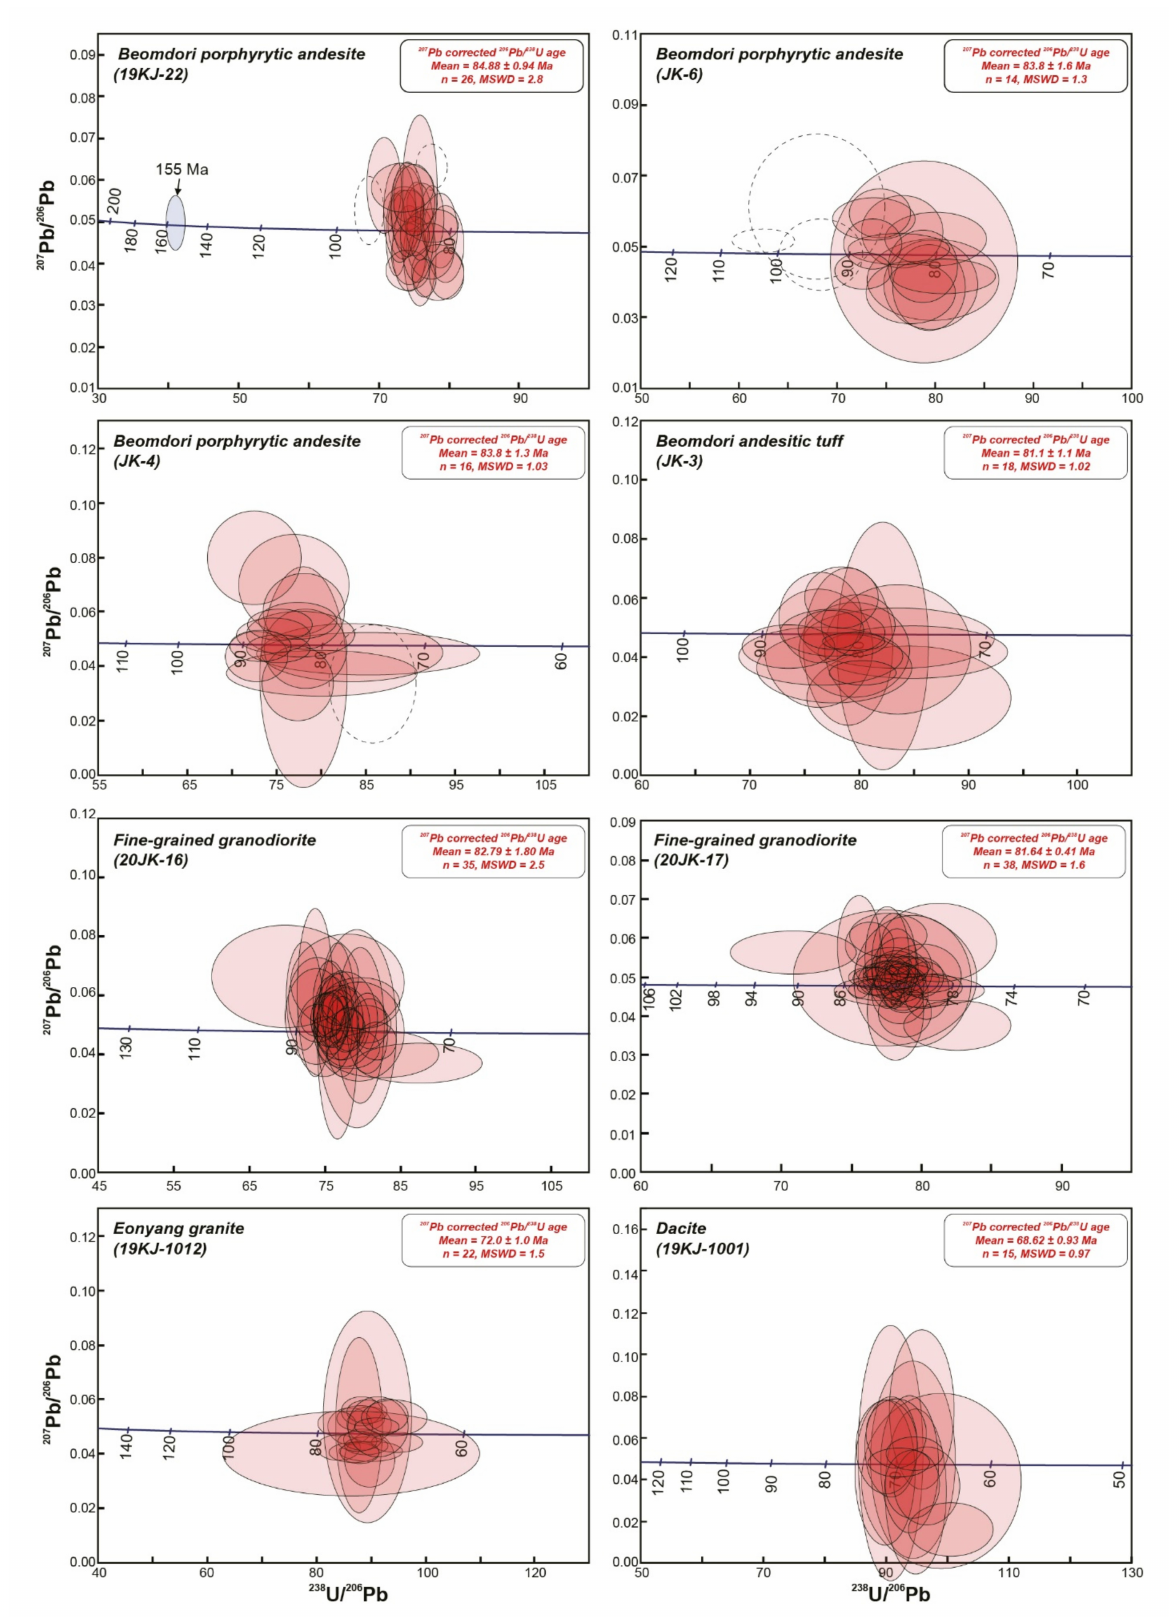
Figure 21. Terra–Wasserburg diagrams for the Beomdori andesitic rocks (19KJ-22, JK-6, JK-4, and JK-3), fine-grained granodiorite (20JK-16, 20JK-17), Eonyang granite (19KJ-1002), and dacite (19KJ-1001). Dashed ellipses are the rejected data by the weighted mean age